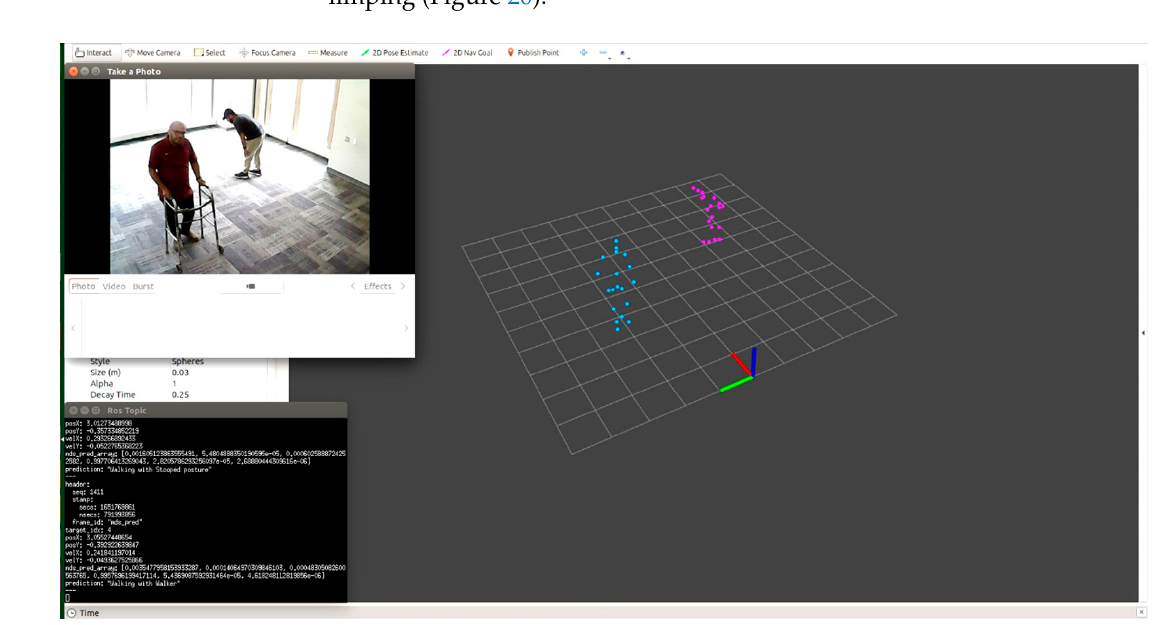
Figure 19. Two subjects, one walking with a walker and one walking with a stooped posture.